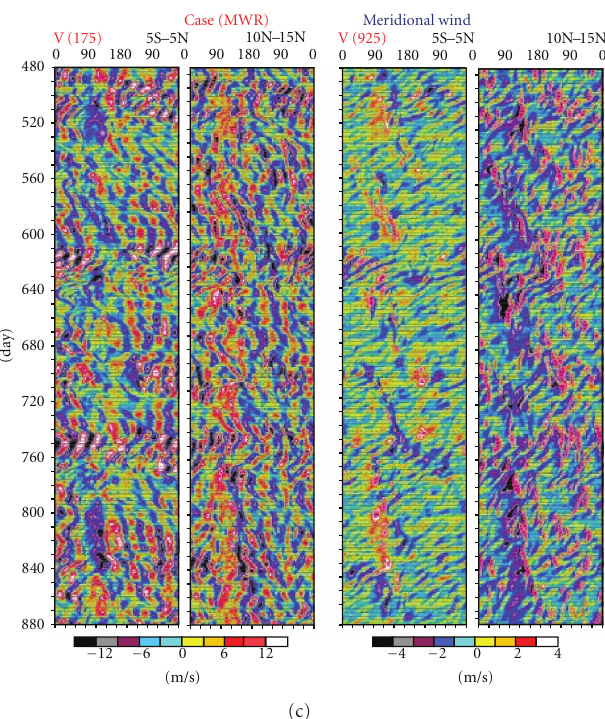
Figure 15: (a) Same as Figure 2 but for case (MWR). The zonal velocity at 175 hPa is shown instead of the surface pressure deviation, (b) upper-level cloud water, a measure of buoyancy (in unit of temperature) at 700hPa, relative humidity at 700 hPa and 900hPa, and temperature anomaly at the lowest level of the model ( P B = 996 hPa), and (c) the upper-level and low-level meridional velocities averaged for 5S–5N and 10N–15N are